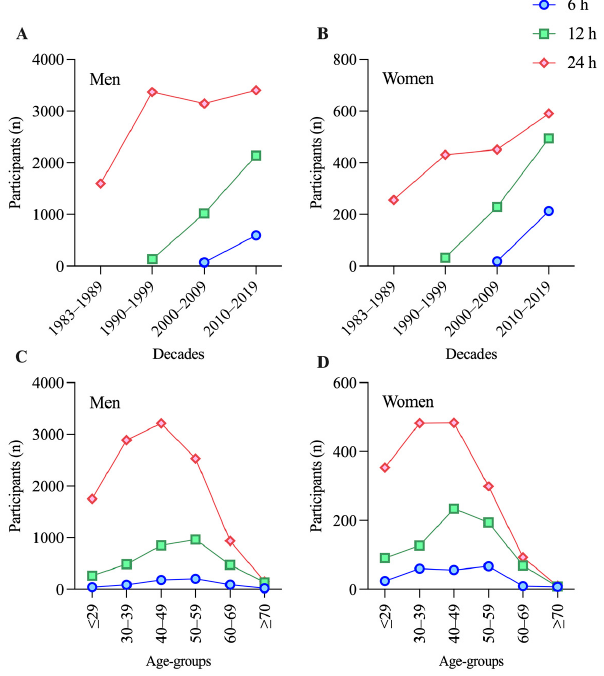
Figure 1. Participation of men and women in 6, 12, and 24 h races. ( A ) Men divided by decade; ( B ) Women divided by decade; ( C ) Men divided by age-group; ( D ) Women divided by age-group.